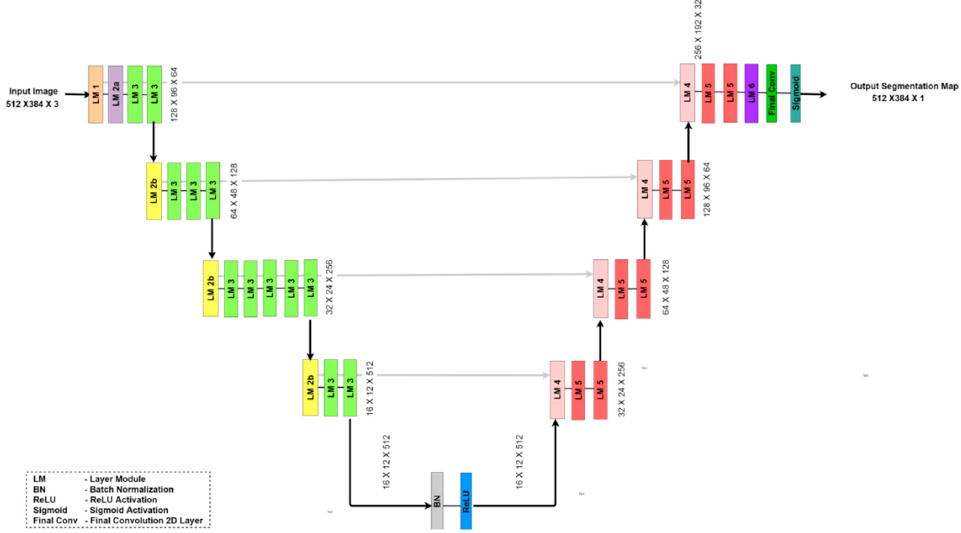
Figure 4. UNBCSM architecture . Figure 4. UNBCSM